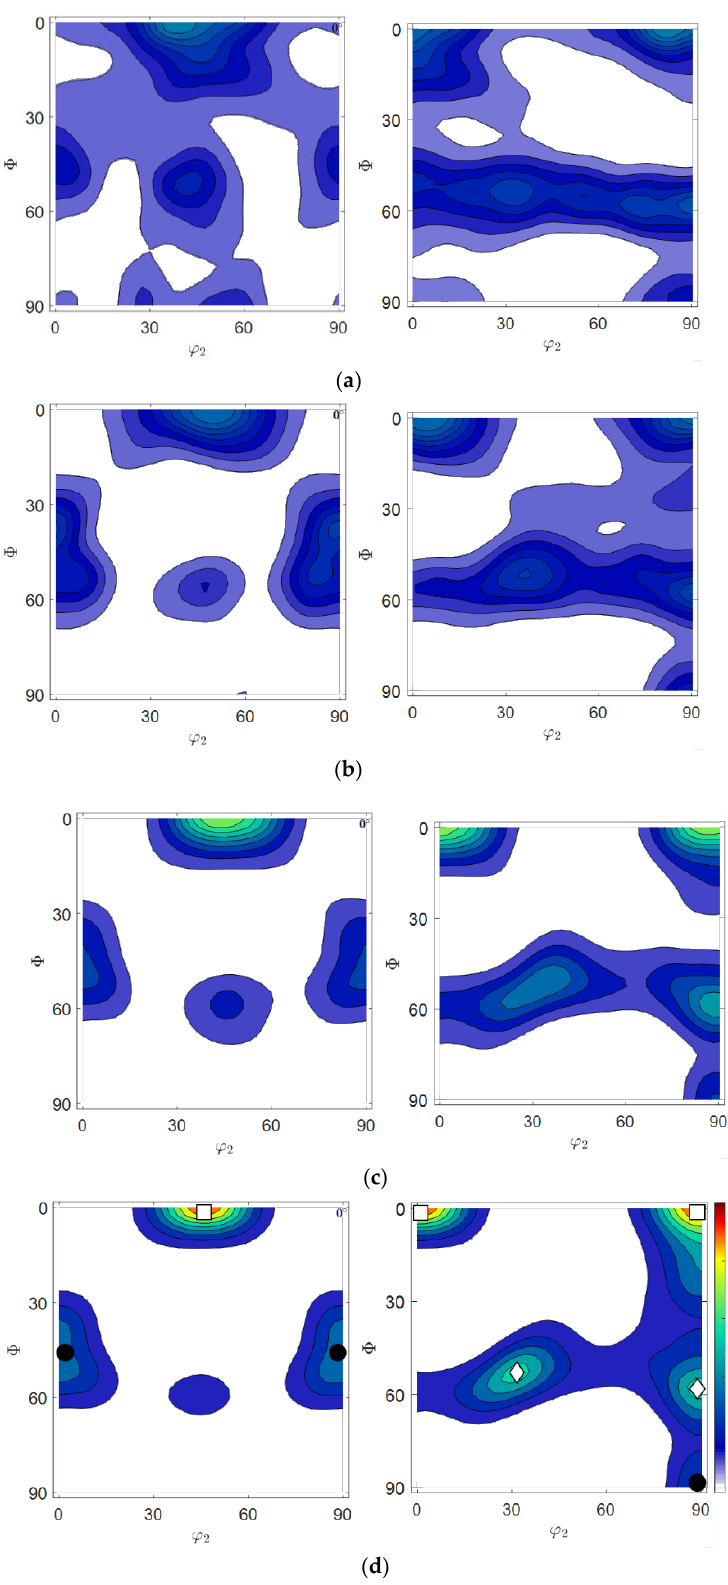
Figure 3. Orientation distribution functions in the φ 1 = 0° (left) and φ 2 = 45° (right), where □: rotation cubic, ◊: { 111}<123> and ●: Goss texture components. ( a ) ε = 2.5%, ( b ) ε = 15%, ( c ) ε = 30%, ( d ) ε = 40%.